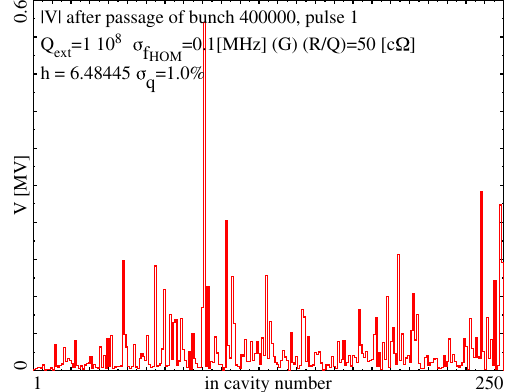
FIG. 73. (Color) Cavity voltages after 1st